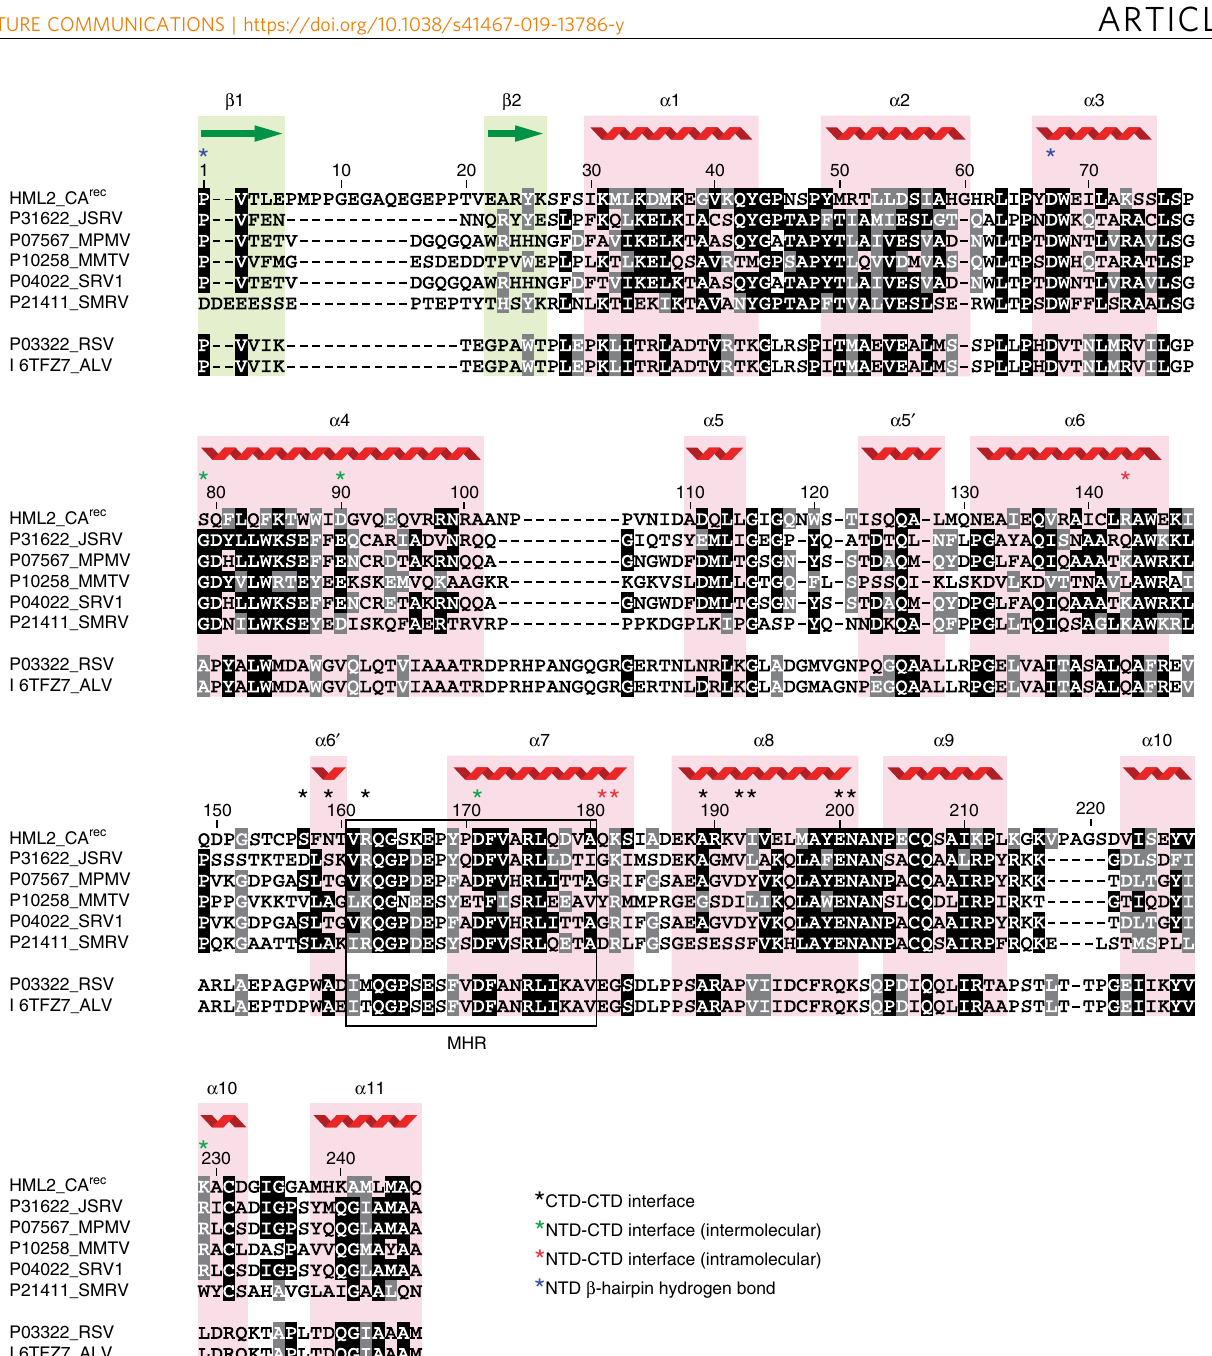
Fig. 5 Structure-based sequence alignment of HML2 CA rec with alpha and betaretroviral CAs. The alignment was performed domain-wise using PROMALS3D, numbering refers to the HML2 CA rec sequence and Uniprot accession codes for each aligned sequence are shown on the left. The fi ve betaretroviral: HML2 CA rec , JSRV, MPMV, mouse mammary tumour virus (MMTV), Simain type D retrovirus (SRV1) and squirrel monkey retrovirus (SMRV), and two alpharetroviral: RSV and avian leukosis virus (ALV) CAs are grouped separately (upper and lower). The regions corresponding to HML2 CA rec secondary structures are shaded red for α -helices and green for β -strands and also displayed pictorially above the sequences. Residues with ≥ 50% identity are highlighted in black, and ≥ 50% similarity in grey. The major homology region (MHR) identi fi ed in the CA of all the orthoretroviruses is boxed. Residues in HML2 CA rec that make inter-molecular CTD – CTD, NTD – CTD or intramolecular NTD – CTD contacts and those that form the conserved NTD β -hairpin hydrogen bond are indicated with the coloured asterisks (black, green, red and blue, self-association ( K A = 3.6 × 10 3 M − 1 ) (Supplementary Fig. 11 and Supplementary Table 4).